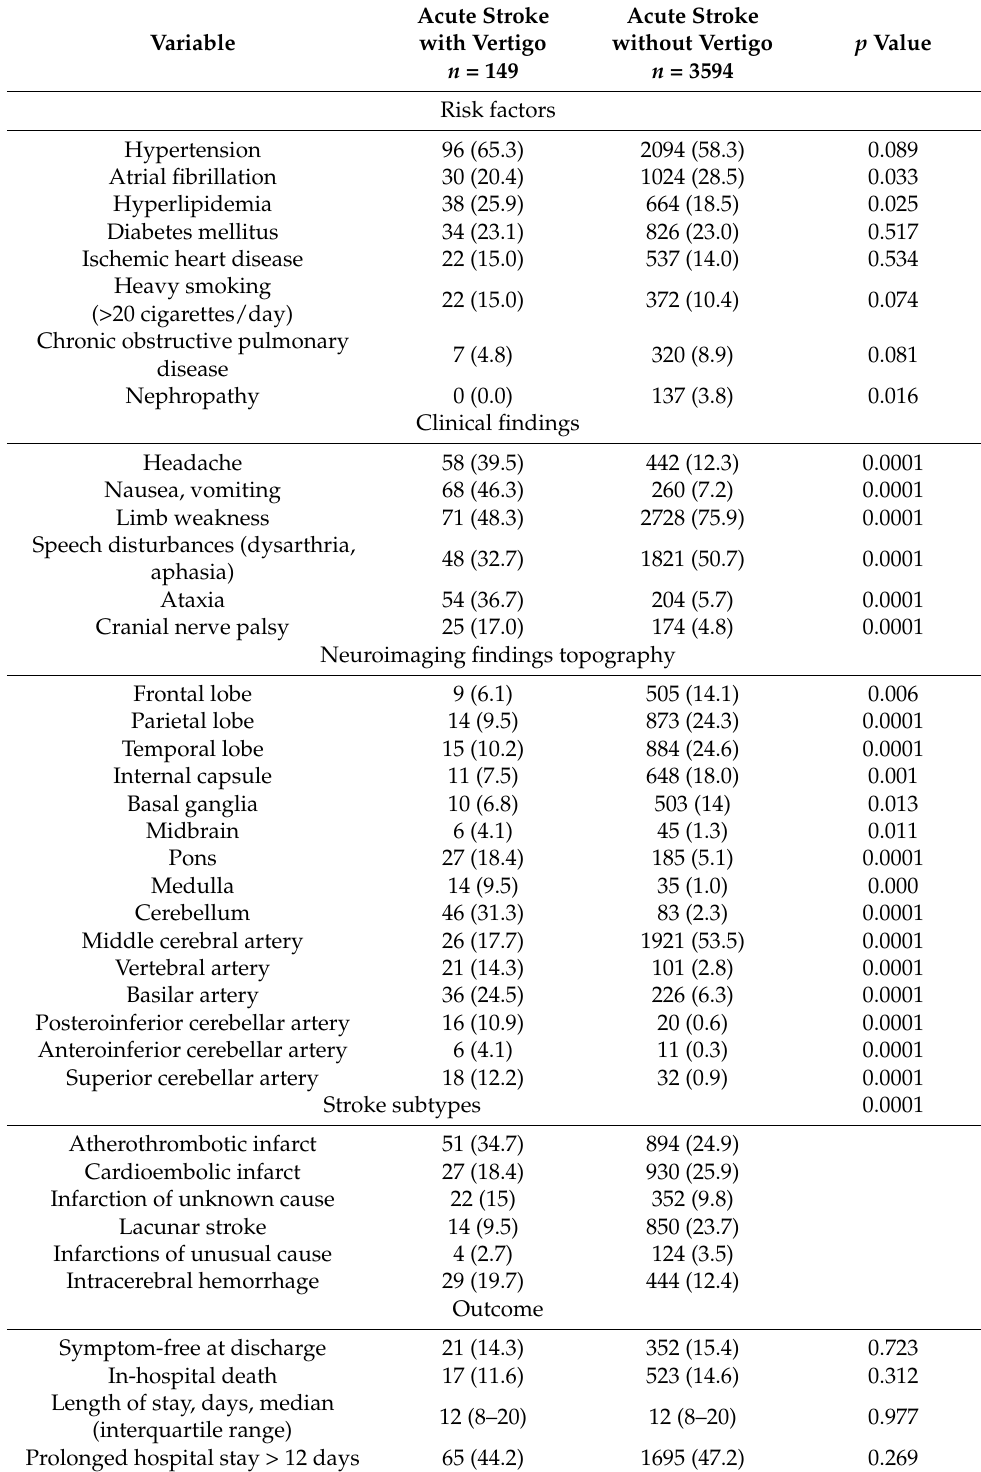
Table 2. Cerebrovascular risk factors, neuroimaging, and outcomes in acute stroke patients with vertigo versus non-vertigo. Acute Variable